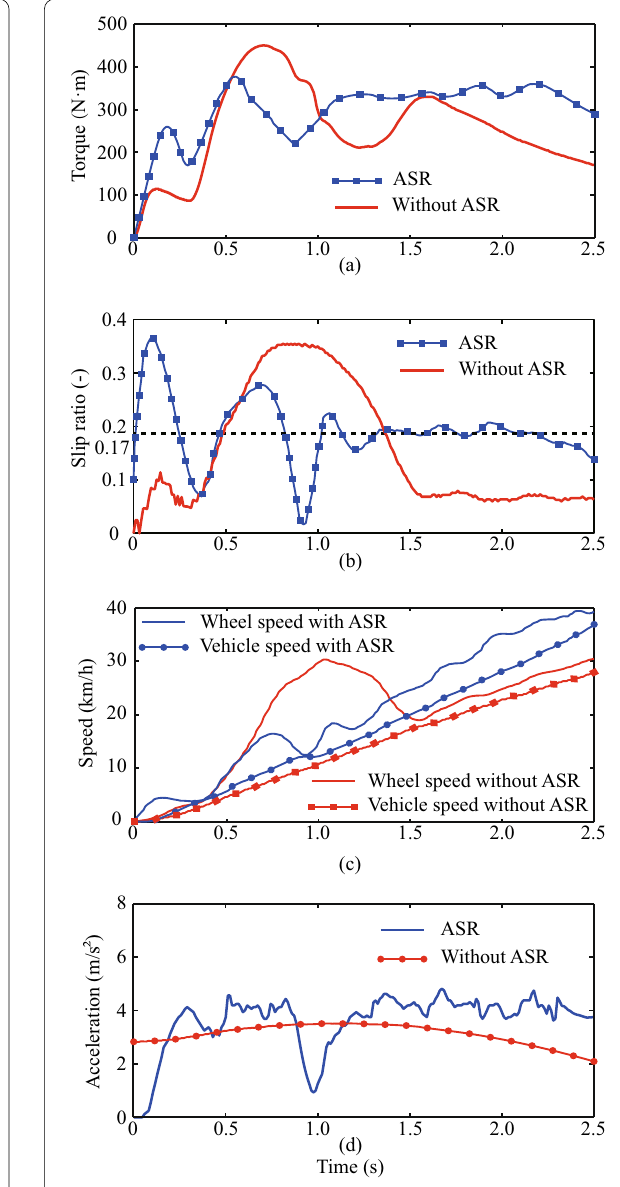
Figure 8 Vehicle test underdry road